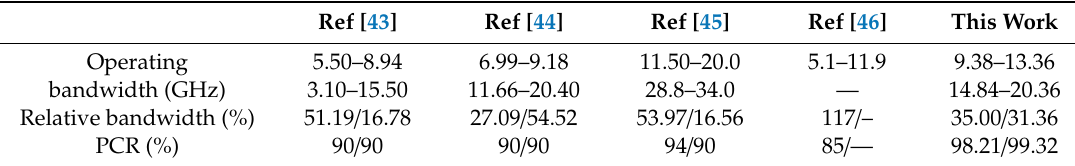
Table 1. Comparison of our design with other polarization converters.